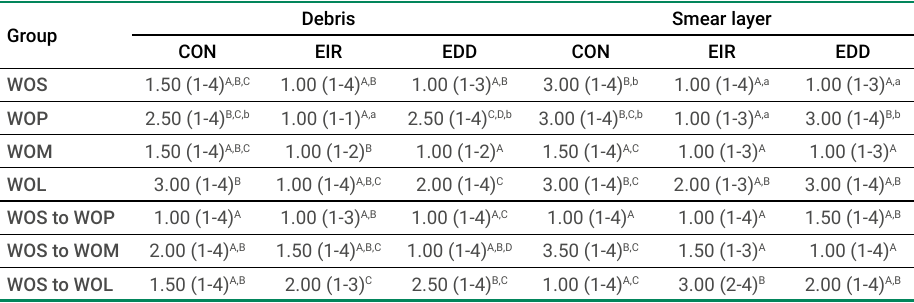
Table 1. Results of debris and smear layer assessment, according to group and irrigation/agitation (median: minimum-maximum). Group